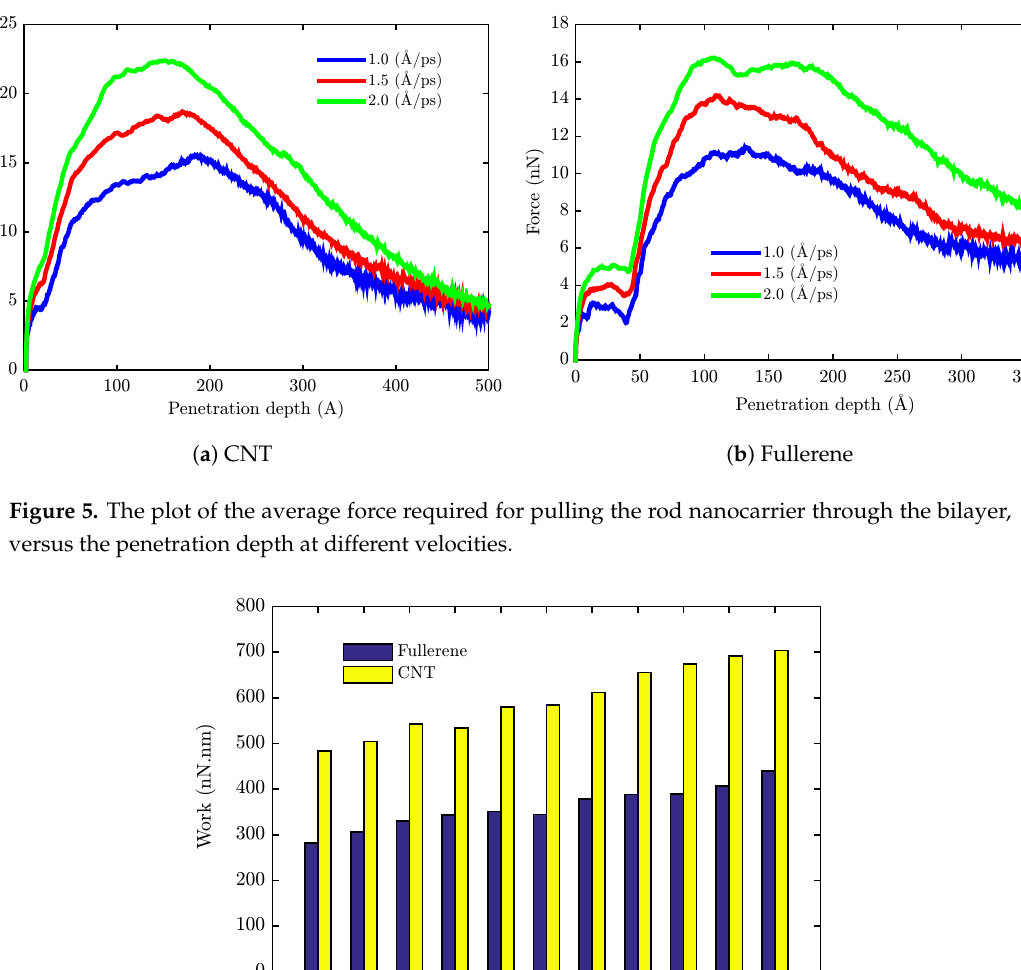
Figure 4. Snapshots of the cell membrane penetration by the fullerene nanocarrier with pulling velocity v = 1.0 Å/ps for ten penetration depths (the lipid bilayer is depicted in Van der Waals representation; fullerene is colored red; and the cartoon representation is employed for insulin chains).